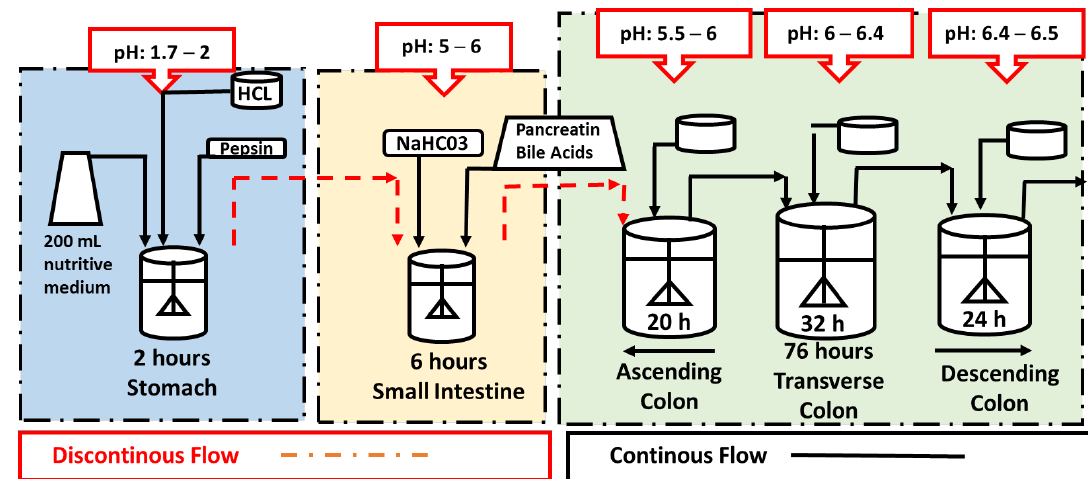
Figure 9. Experimental conditions of the in vitro gastrointestinal digestion and colonic fermentation in a dynamic model digestor (AINIA, Valencia, Spain).